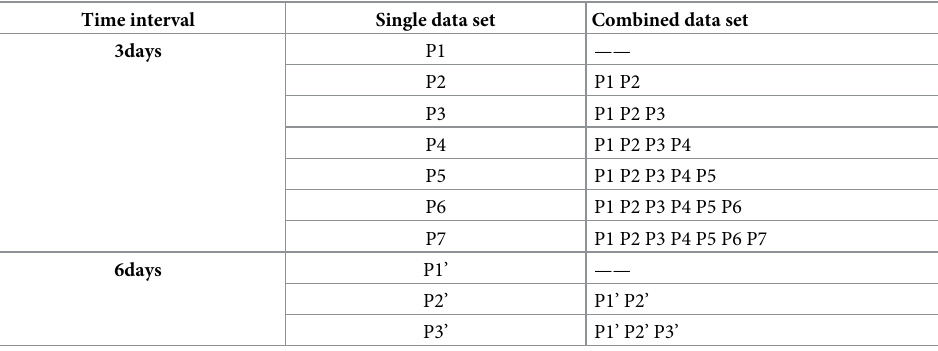
Table 2. Combination method of data sets for